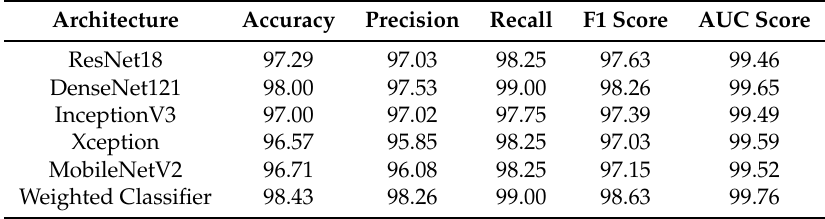
Table 6. Accuracy, precision, recall, F1 score, and AUC score corresponding to different architectures.